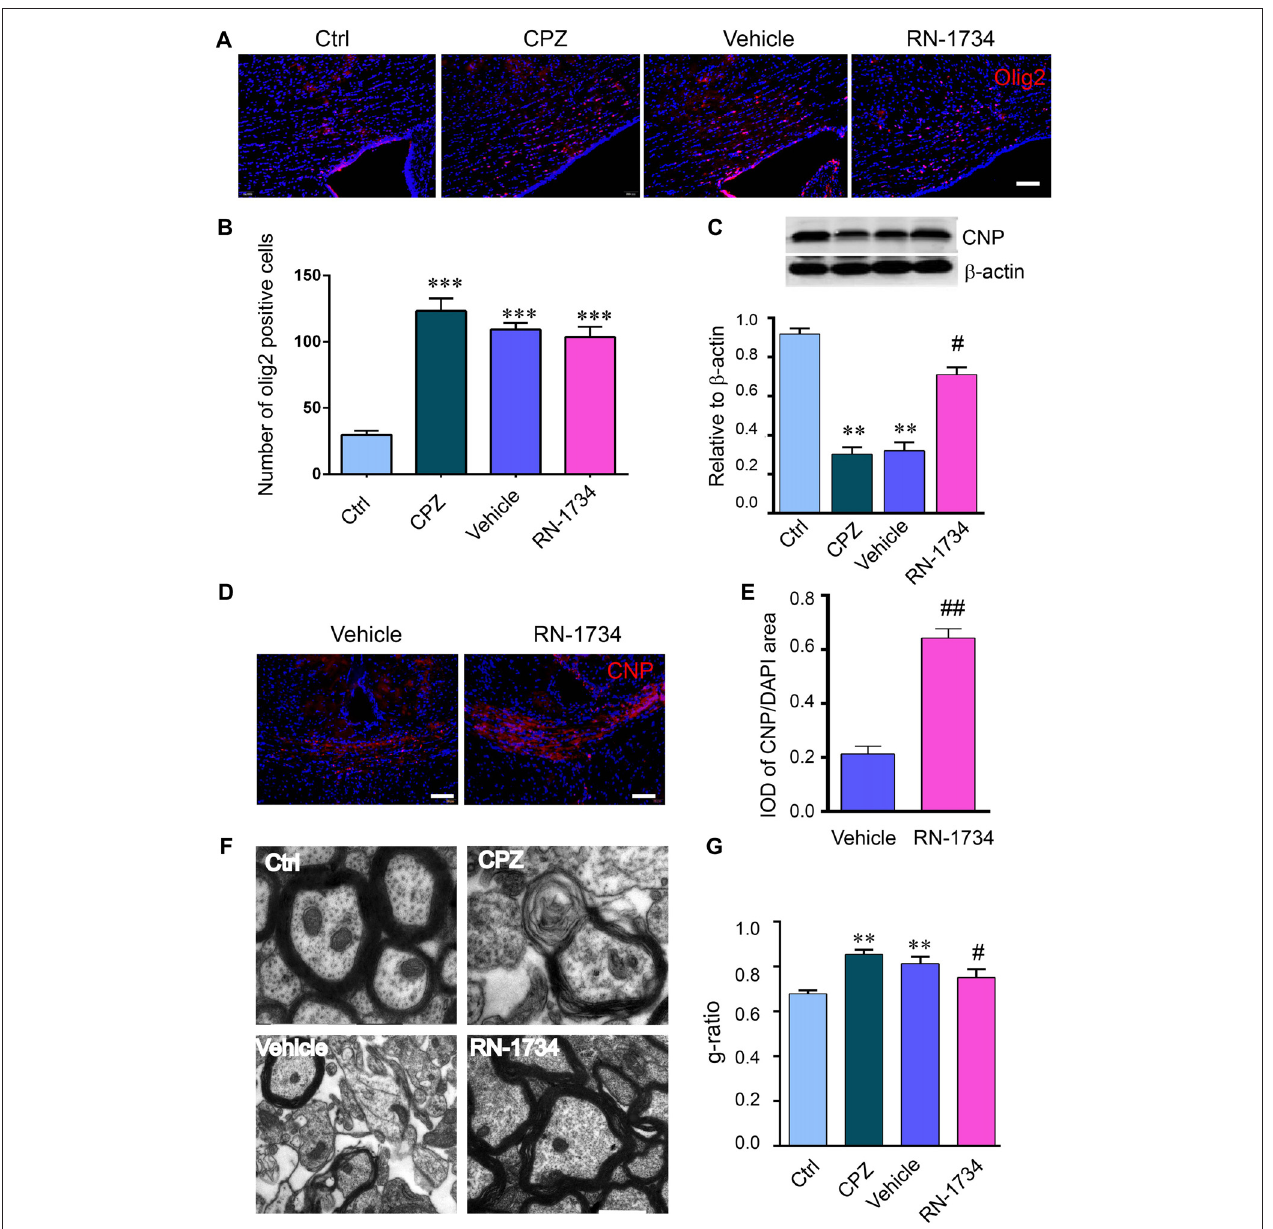
FIGURE 2 | Inhibition of TRPV4 activity alleviated demyelination induced by CPZ. (A,B) Images and quantitative analysis of olig2 immunostaining cells in the Ctrl, CPZ, vehicle-treated (vehicle) and RN-1734-treated (RN-1734) groups ( n = 4). Scale bar = 50 µ m. (A–C) Western blot analysis of the corpus callosum CNP in the control, CPZ, vehicle and RN-1734 groups ( n = 3). (B–E) Immunofluorescence and quantitative analysis of CNP-positive cells in the vehicle group and the RN-1734 group ( n = 4). Scale bar = 50 µ m. (D–F) Representative images from electron microscopy of the corpus callosum in the control, CPZ, vehicle and RN-1734 groups. (E–G) Quantitative analysis of the g- ratio of the myelin sheath ( n = 3). Scale bar = 500 nm. The data are shown as the mean ± SEM. ∗∗ P < 0.01, ∗∗∗ P < 0.001 vs. the Ctrl group; # P < 0.05, ## P < 0.01 vs. the vehicle group.